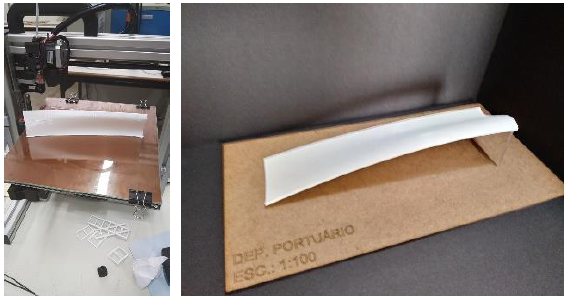
Figure 10: 3d printing process and half-a-module produced.